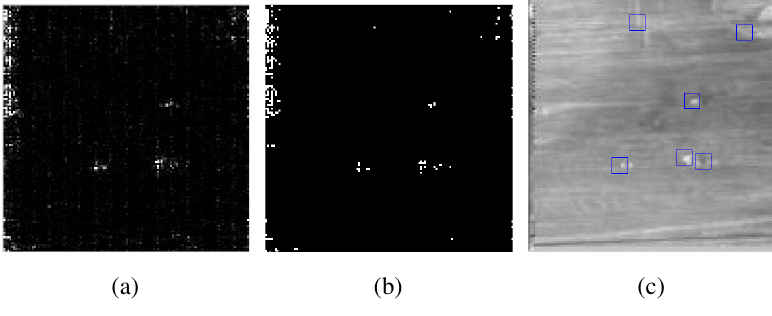
Figure 3. Figures of phase spectrum Fourier transform (PFT). ( a ) saliency map of PFT method; ( b ) result of threshold operation; ( c ) final result marked by blue block.